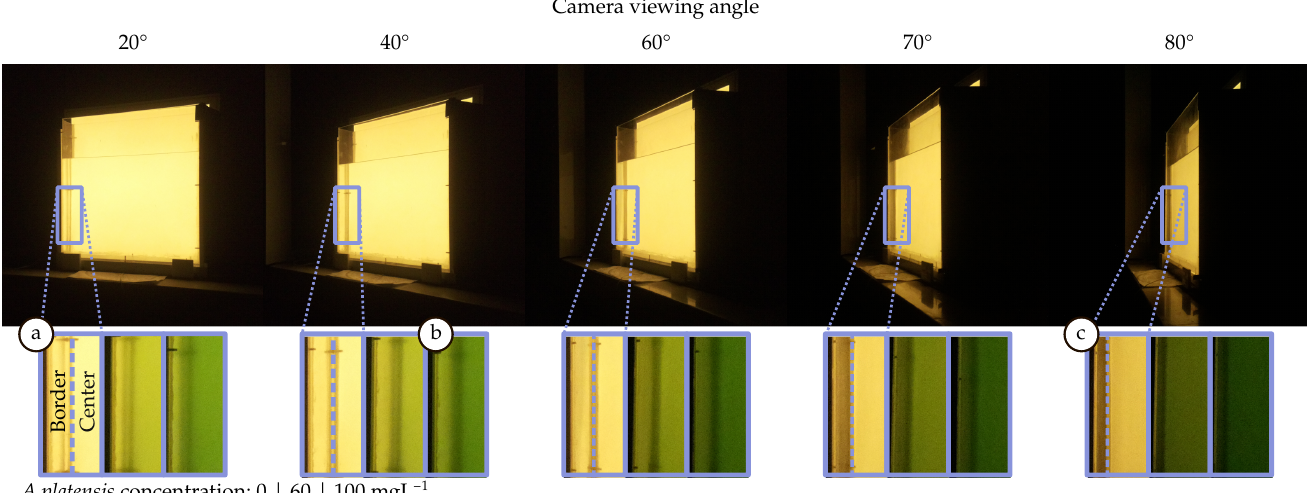
Figure 9. Illustrative example of the results obtained in the indoor